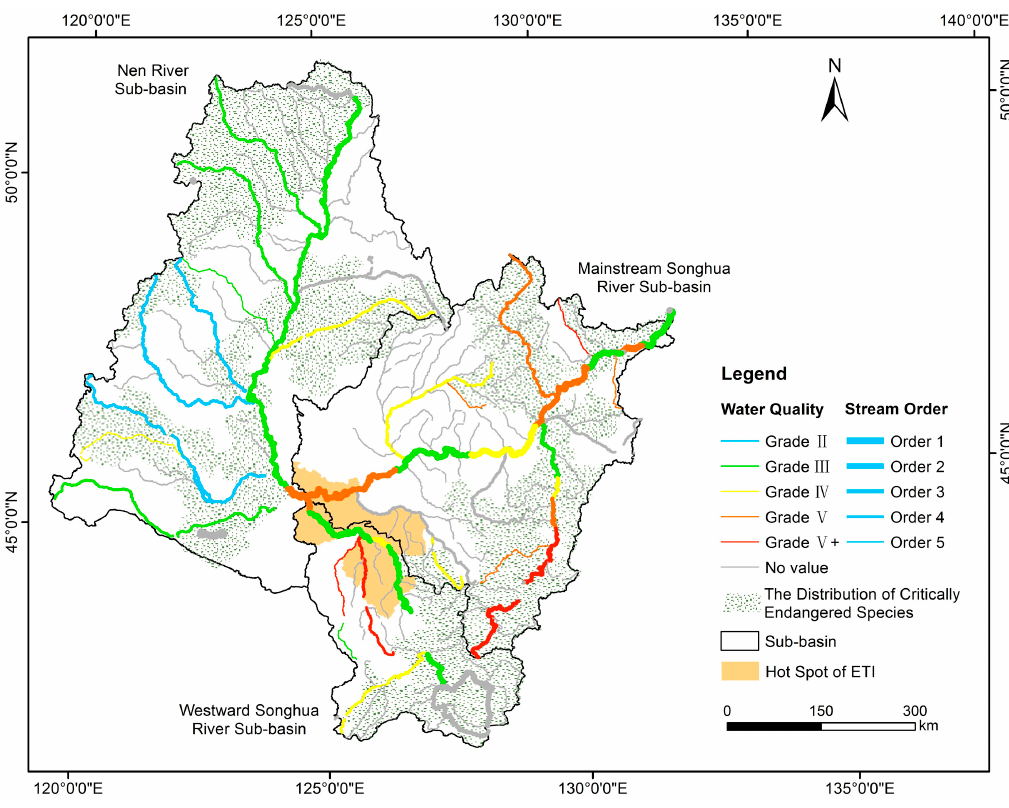
Figure 4. The spatial relationships between hot spot locations of ETI and water quality as well as the distribution of critically endangered species in the SRB.